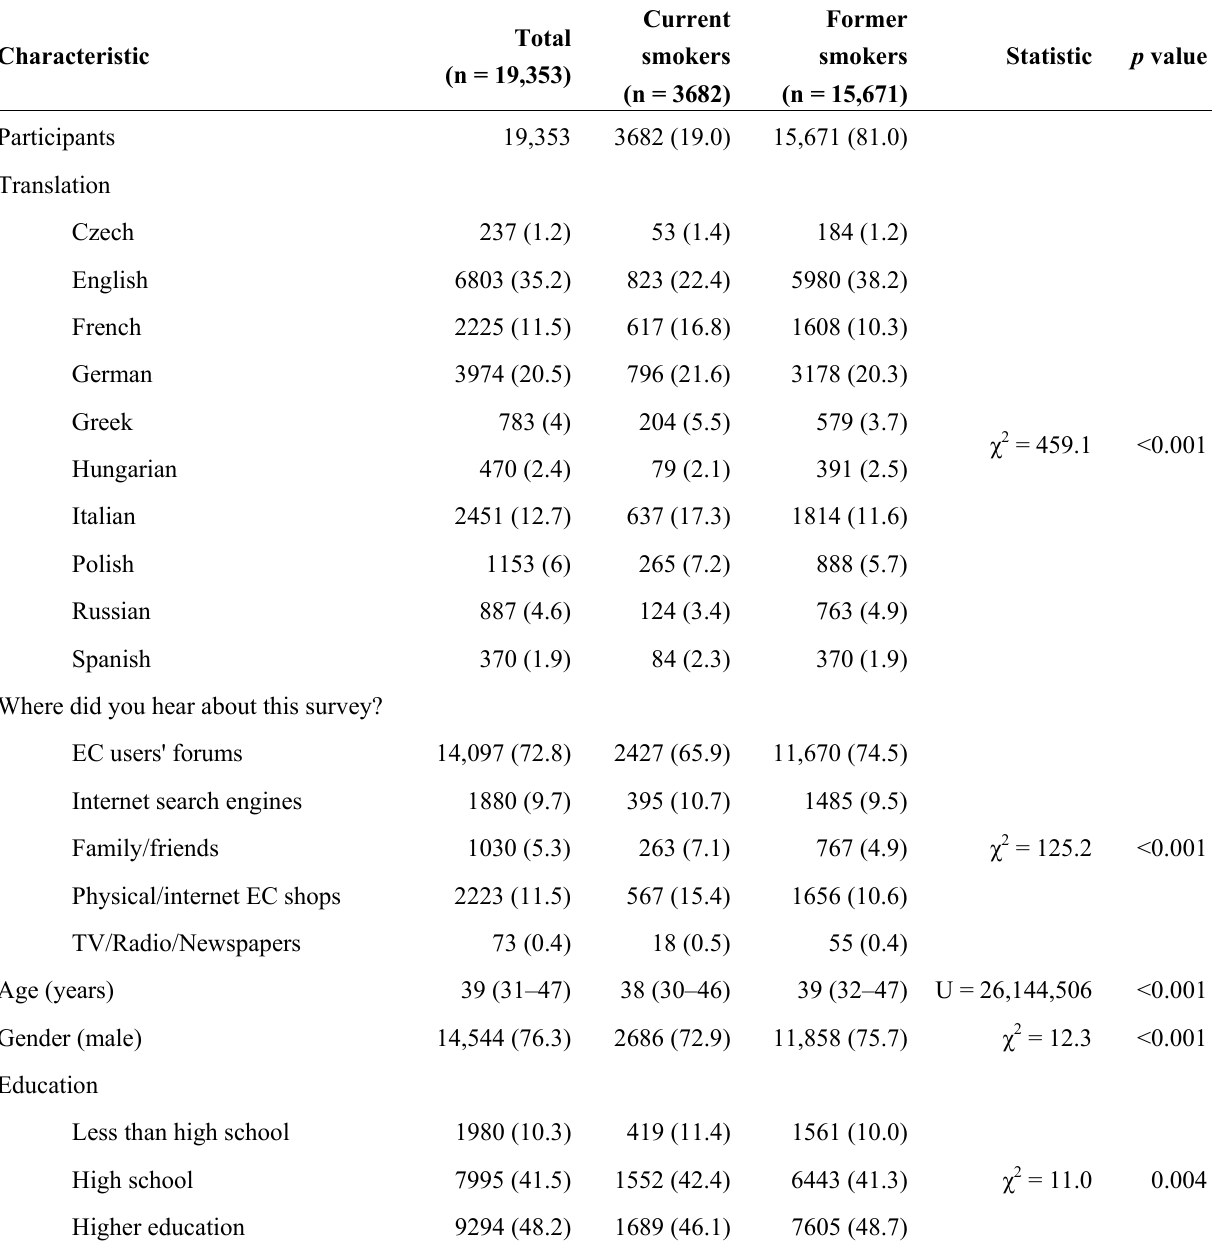
Table 1. Baseline characteristics of participants